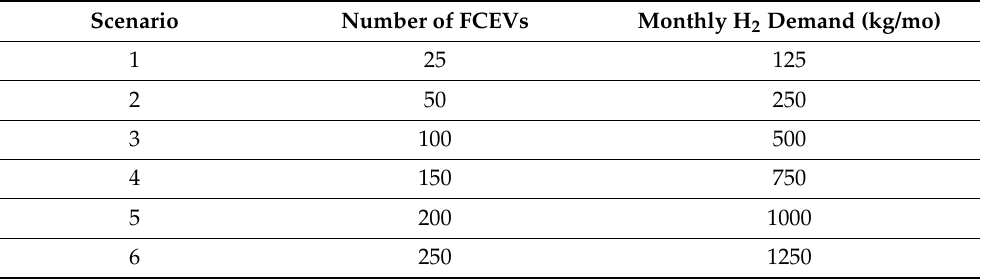
Table 2. Scenarios of demand based on FCEVS